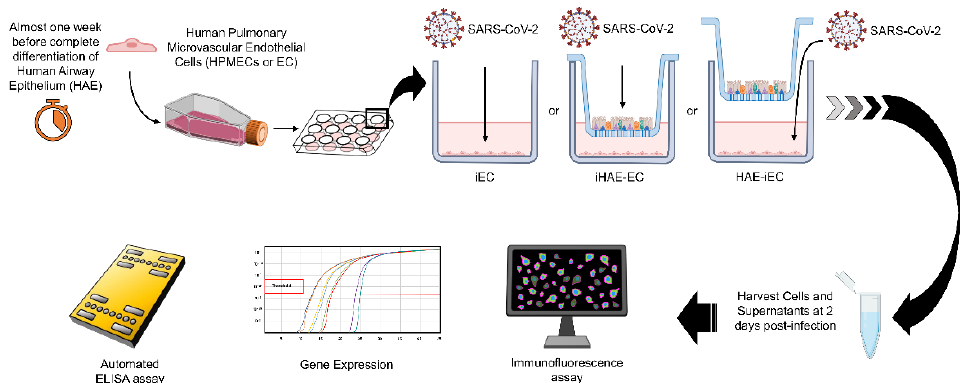
Figure 1. Experimental model and design. Almost one week before the complete differentiation of Human Airway Epithelium (HAE), Human Pulmonary Microvascular Endothelial Cells (ECs) were thawed and expanded. HAE were then co-cultured with ECs (HAE-EC). Afterward, three different culture conditions were performed: (i) ECs were infected and cultured alone (iEC); (ii) ECs were infected and cultured with HAE (HAE-iEC) and (iii) uninfected ECs were cultured with infected HAE (iHAE-EC). Samples from infected cultures (supernatants and cells) were collected for inflammatory cytokines quantification, gene expression, and immunofluorescence analysis at 2-days post-infection.